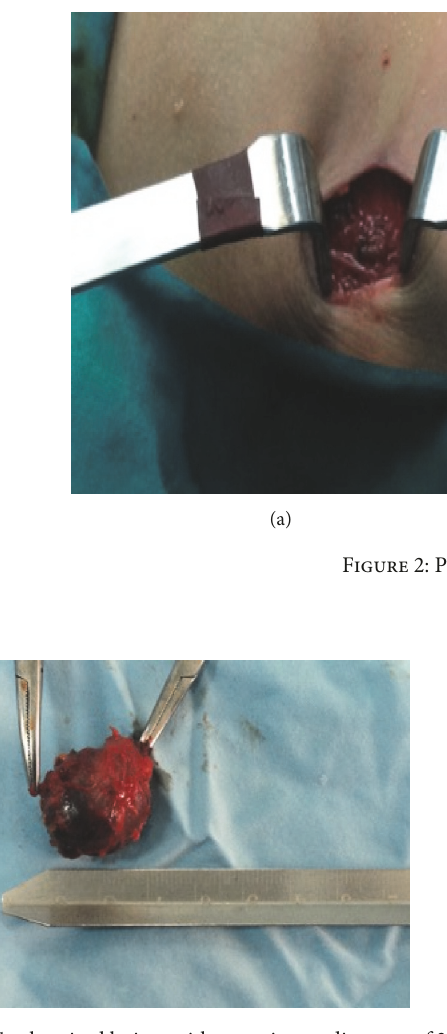
Figure 3: Total excised lesion, with a maximum diameter of 3.2 cm. Notice the intense hemorrhagic perfusion of its capsule.